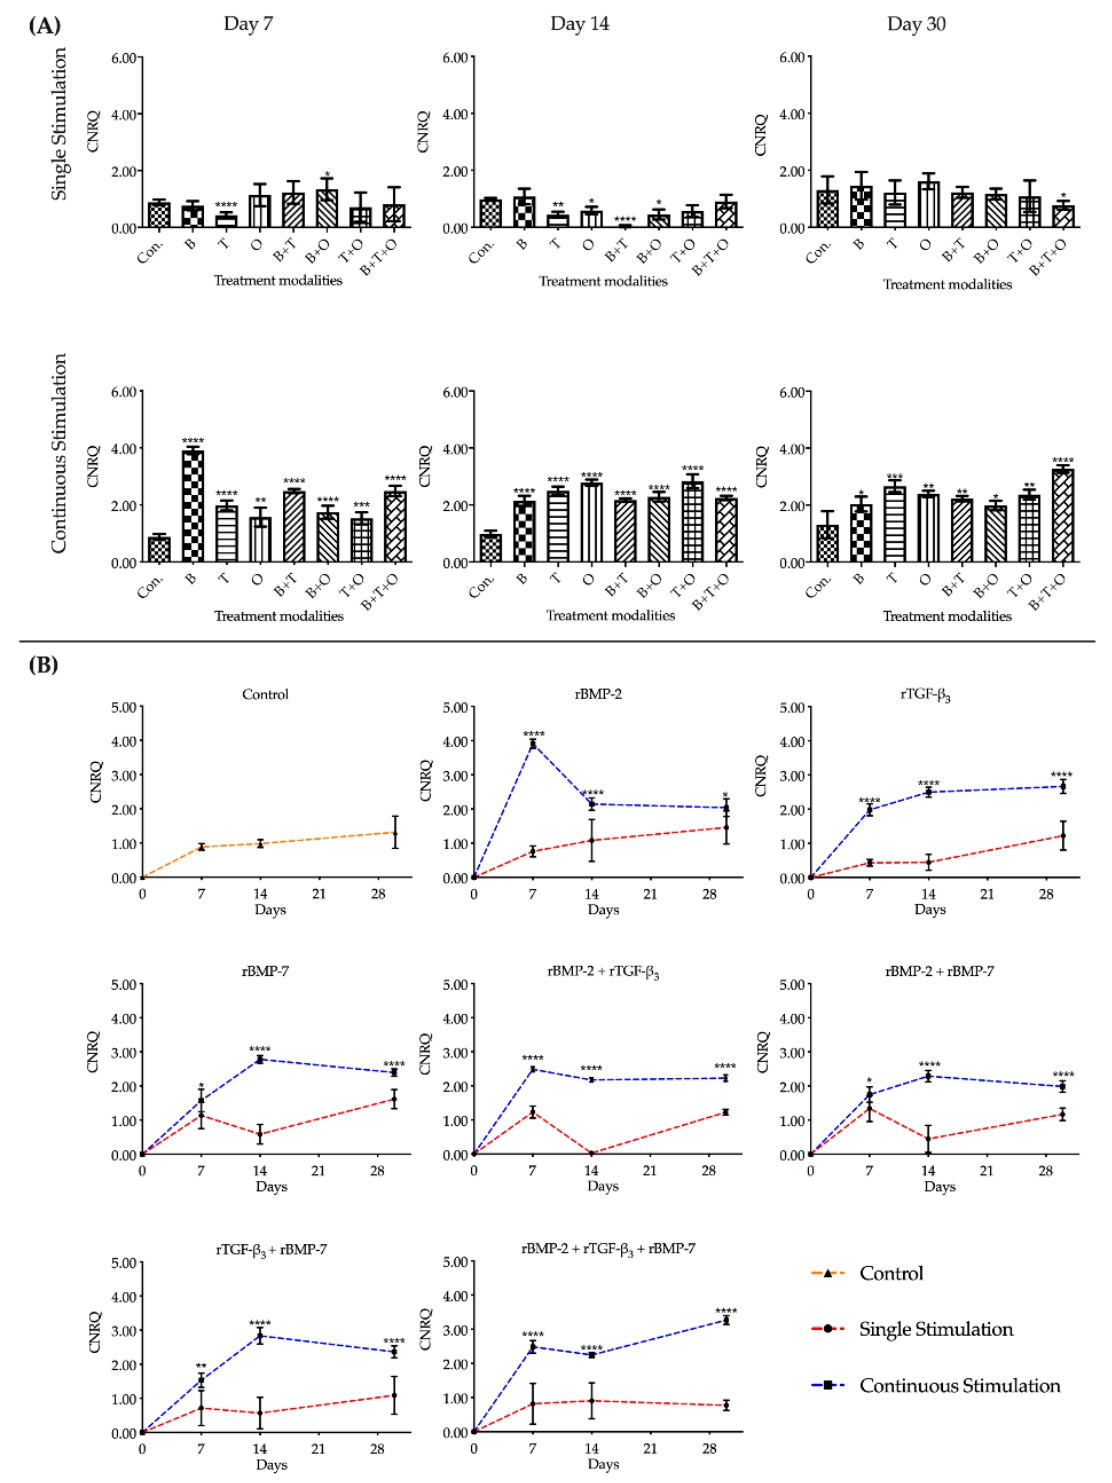
Figure 1. The analyses of the relative gene expression levels of aggrecan ( ACAN ). The results were presented as calibrated normalized relative quantity (CNRQ). ( A ) Comparisons between each experimental group under di ff erent stimulation modes and the corresponding control group at day 7, 14 and 30 using one-way ANOVA. ( B ) Comparisons between the experimental groups where growth factors were applied continuously and the corresponding 48 h withdrawal groups at day 7, 14 and 30 using two-way ANOVA. Con. = control group, B = rBMP-2 treated group, T = rTGF- β 3 treated